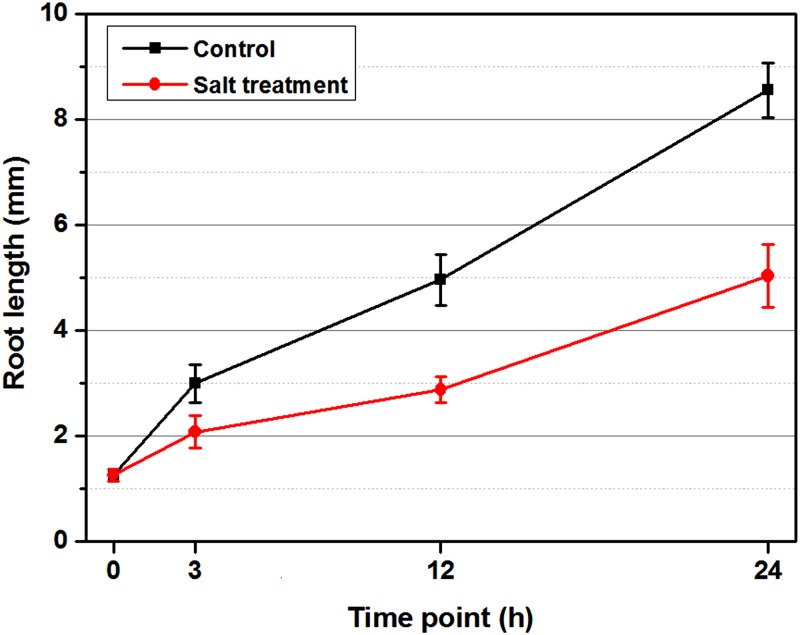
Effect of salt (NaCl) on Brassica napus roots length during the 24-hour time course.Equal numbers of seeds were placed in three petri dishes under control (H2O treatment) and salt treatment (ST), separately, and placed randomly in the incubator. At each time point, the uniform germinated seeds under both treatments were sampled from every dish to capture root-length values. The whole experiment was carried out on three replicates. The error bars represent the standard error (SE) of the mean root length.